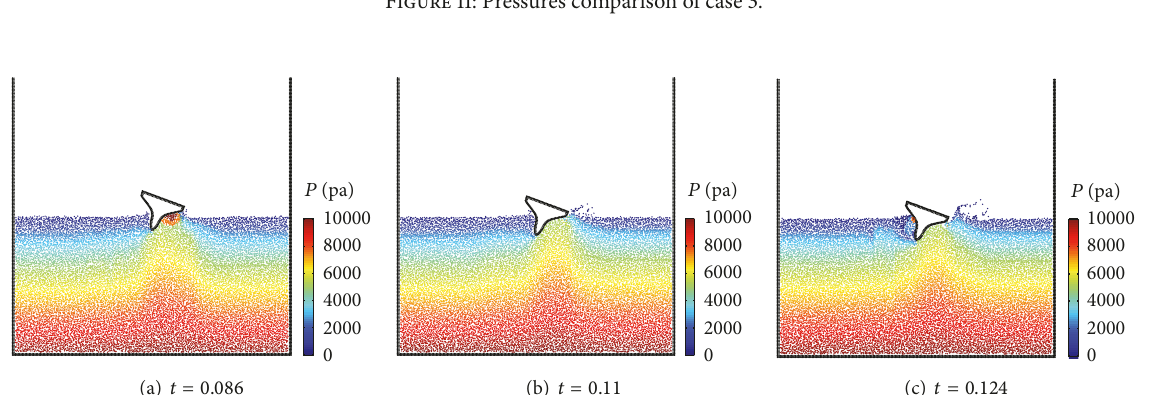
Figure 11: Pressures comparison of case 3.